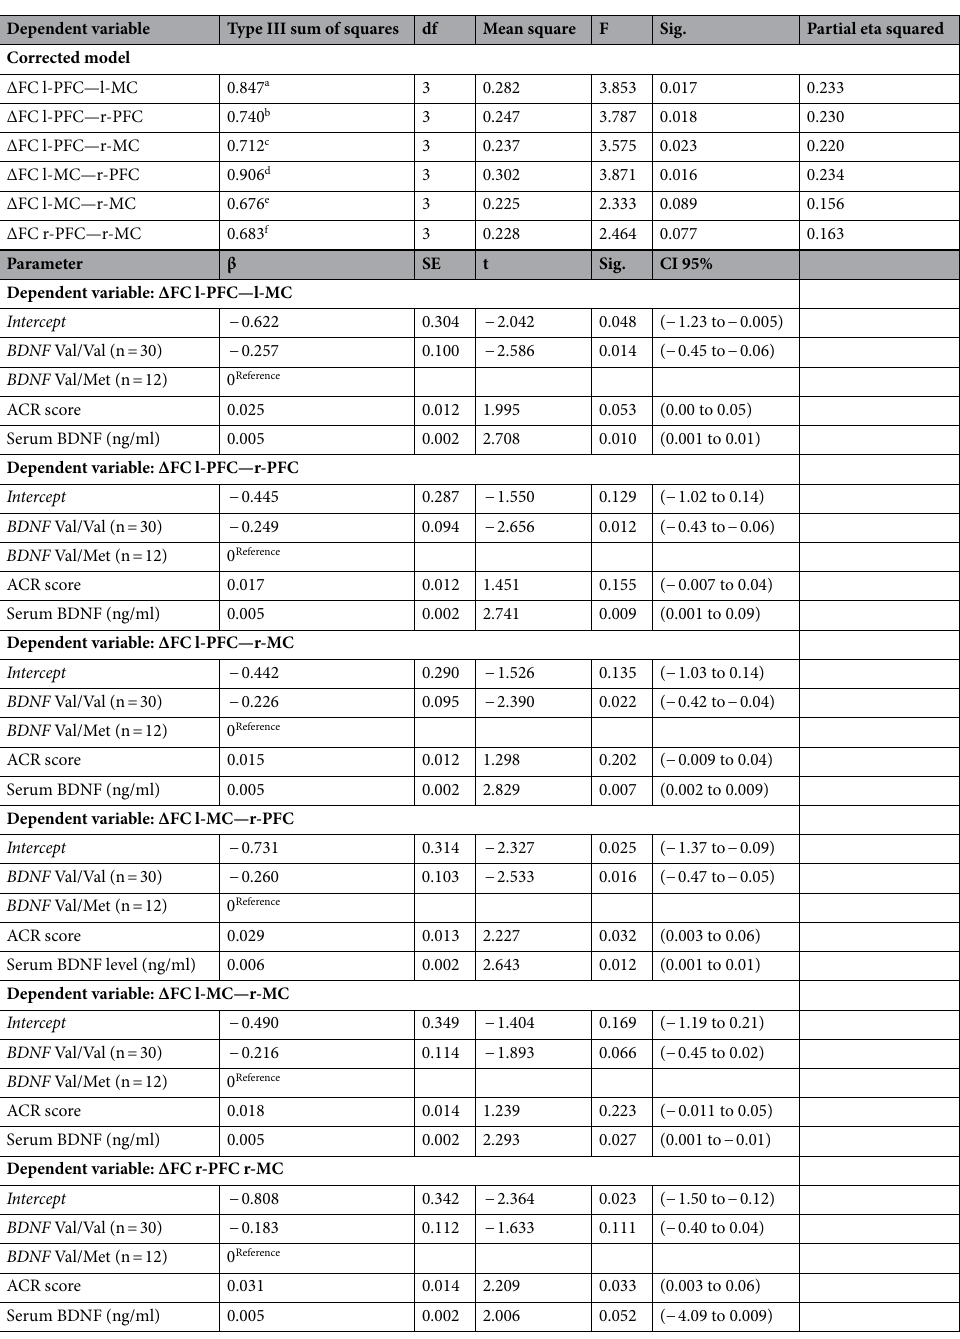
Table 4. MANCOVA analysis of the relationship between the ∆FC regions of interest before and after a cold pressor test according to the BDNF Val/Met genotype (n = 42). Df degrees of freedom . χ 2 Wald Chi- Square . CI confidence interval . β regression coefficient . SE standard error . Sig. p -value. BDNF brain-derived neurotrophic factor . ACR American College of Rheumatology . ΔFC functional connectivity . Val/Val Val66Val homozygous . Val/Met Val66Met heterozygous . PFC prefrontal cortex . MC motor cortex . -l left . -r right . ACR score American College of Rheumatology score for fibromyalgia diagnosis . BDI-II Beck Depression Inventory II. a R Squared = 0.233 (Adjusted R Squared = 0.173). b R Squared = 0.230 (Adjusted R Squared = 0.169). c R Squared = 0.220 (Adjusted R Squared = 0.159). d R Squared = 0.234 (Adjusted R Squared = 0.174). e R Squared = 0.156 (Adjusted R Squared = 0.089). f R Squared = 0.163 (Adjusted R Squared =